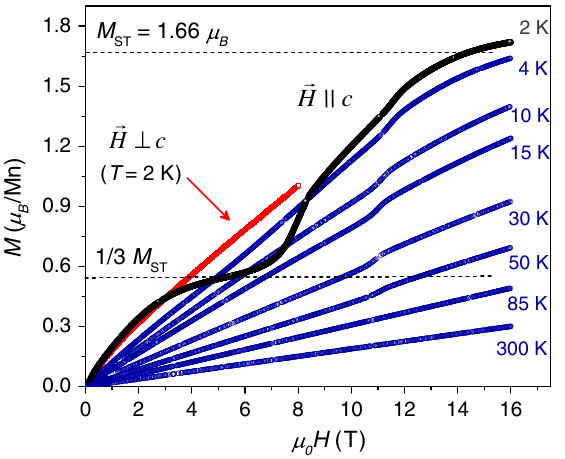
FIG. 6. Low-temperature region of the heat-capacity data FIG. 5. Isothermal magnetization ( M vs H ) curves measured at measured in applied magnetic fields oriented parallel (a) and selected temperatures ranging from 2 to 300 K for magnetic fields perpendicular (b) to the c -axis direction. (c) The partial T − μ 0 H applied along the c axis (black and blue curves). The magneti- magnetic phase diagram deduced from heat-capacity data. For zation curve measured at 2 K for magnetic fields applied ⃗ H k c denoted by solid symbols, the lowest transition ( T ) shifts perpendicular to the c axis is shown in red color and indicated N 3 to lower temperatures with increasing the magnetic field, while by the arrow. The magnetization values corresponding to the ⃗ H ⊥ c transition displays a domelike shape. For repre- the T plateau state ( 1 = 3 M ) and saturation M of the triangular N 2 ST ST sented by open symbols, the T transition evolves into two magnetic sublattice are indicated by a dashed line. As described N 3 distinct transitions ( T and T (cid:3) ), while the T transition in the text, the triangular layer contains only one-third of the total N 3 N 2 N 3 magnetic ions of the system. increases